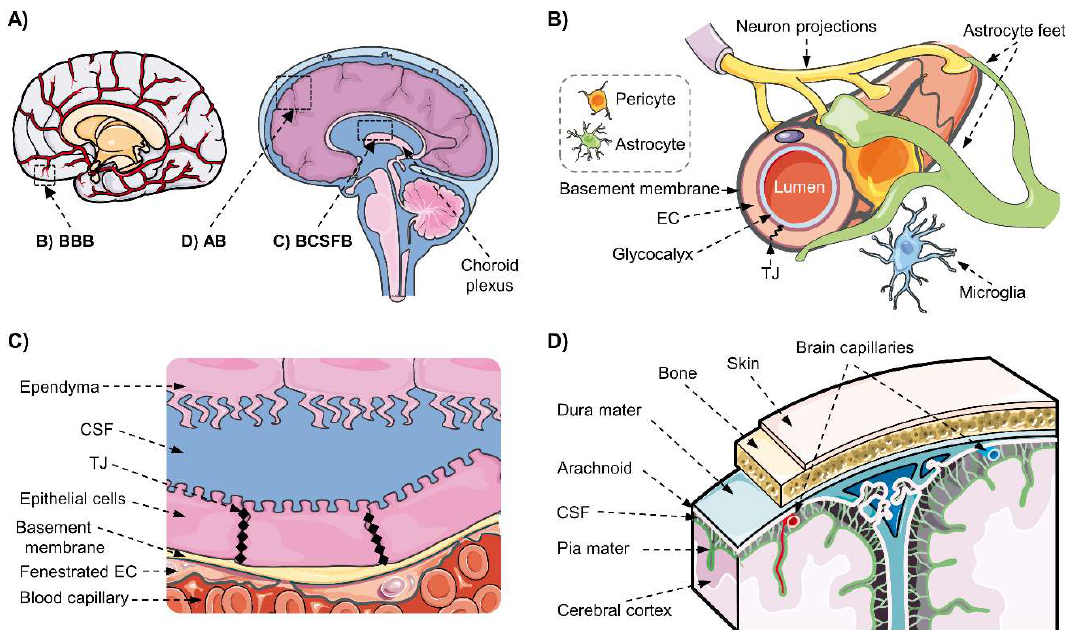
Figure 1. Human blood–brain interfaces. ( A ) There are three main interfaces regulating the exchanges between blood and brain (A), left), either directly to the parenchyma or through the cerebrospinal fluid (CSF; A), right). ( B ) The blood–brain barrier (BBB) is formed mainly by the brain microvascular endothelial cells (EC), attached by tight junctions (TJ), but their specialized phenotype and function are regulated and maintained by the neurovascular unit (NVU) formed by the basement membrane and neighboring cells including pericytes, astrocytes, neurons, and microglia. ( C ) The blood–cerebrospinal fluid barrier (BCSFB) is formed by the tightly jointed epithelial cells of the choroid plexus (CP), which cover the fenestrated EC of the CP capillaries. ( D ) The meninges are composed of three layers: the outermost fibrous sheet of dura mater, the arachnoid mater and the pia, both enclosing CSF in the subarachnoid space; the arachnoid cells present tight junctions and form the blood–arachnoid barrier (BAB). Created using images from “smart Servier Medical Art”, Creative Commons License, 2019.